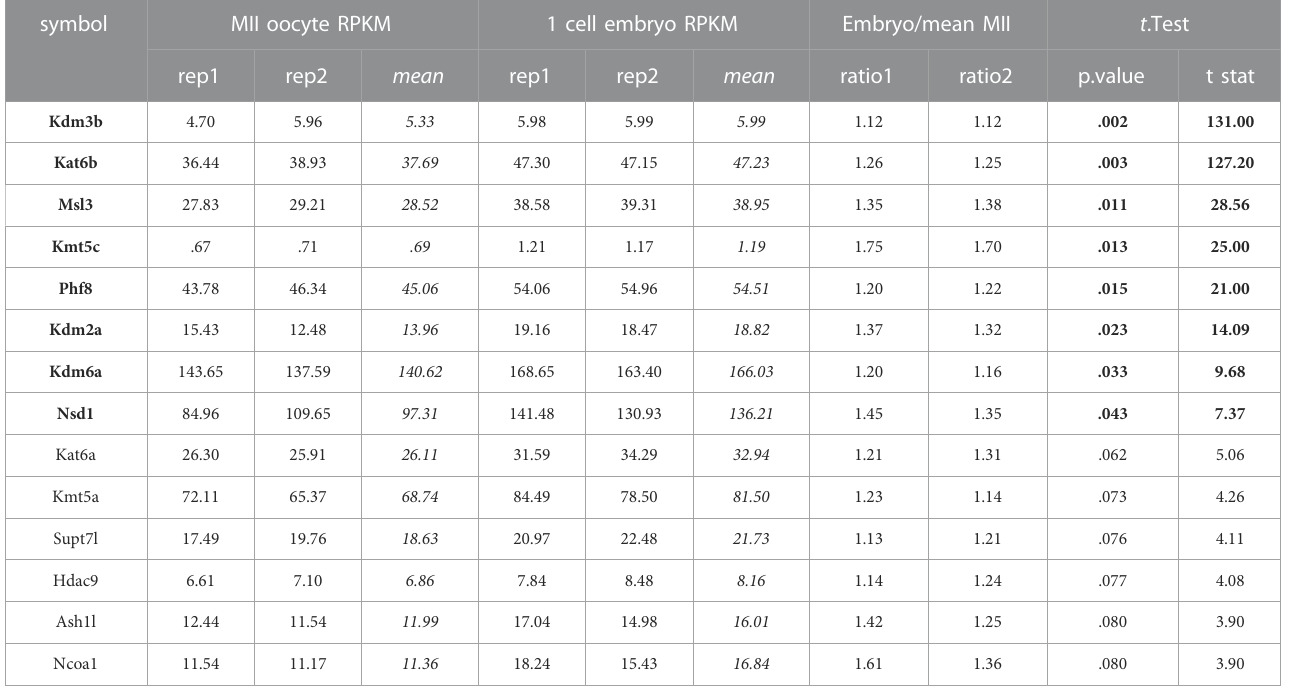
TABLE 2 Candidate epigenetic enzymes for paternalcontribution. RPKM values obtained for MIIoocytes and one cell embryos enzymes from GSE169632 (Zhang et al., 2022). Embryo RPKMs were converted to ratio over mean MII oocytes RPKM. One sample t-test, values in black font p < .05, values in regular font p < .1. symbol MII oocyte RPKM 1 cell embryo RPKM Embryo/mean MII t .Test